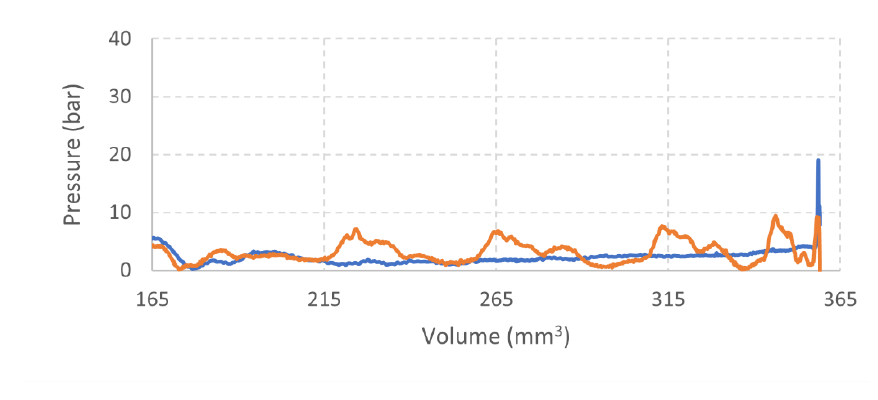
Table 6. Pressure behavior during suction, compression, and delivery phases.